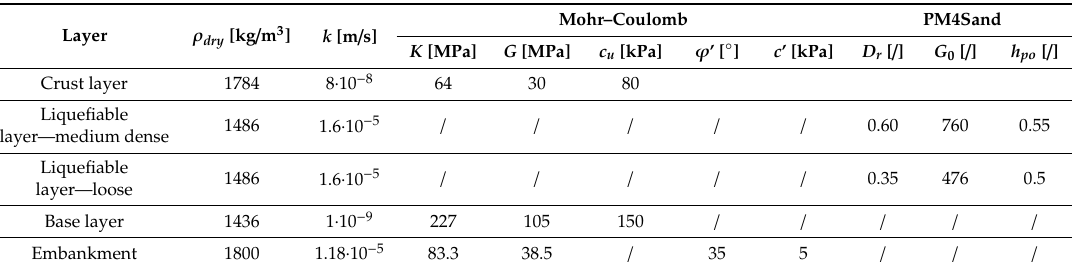
Table 3. Material